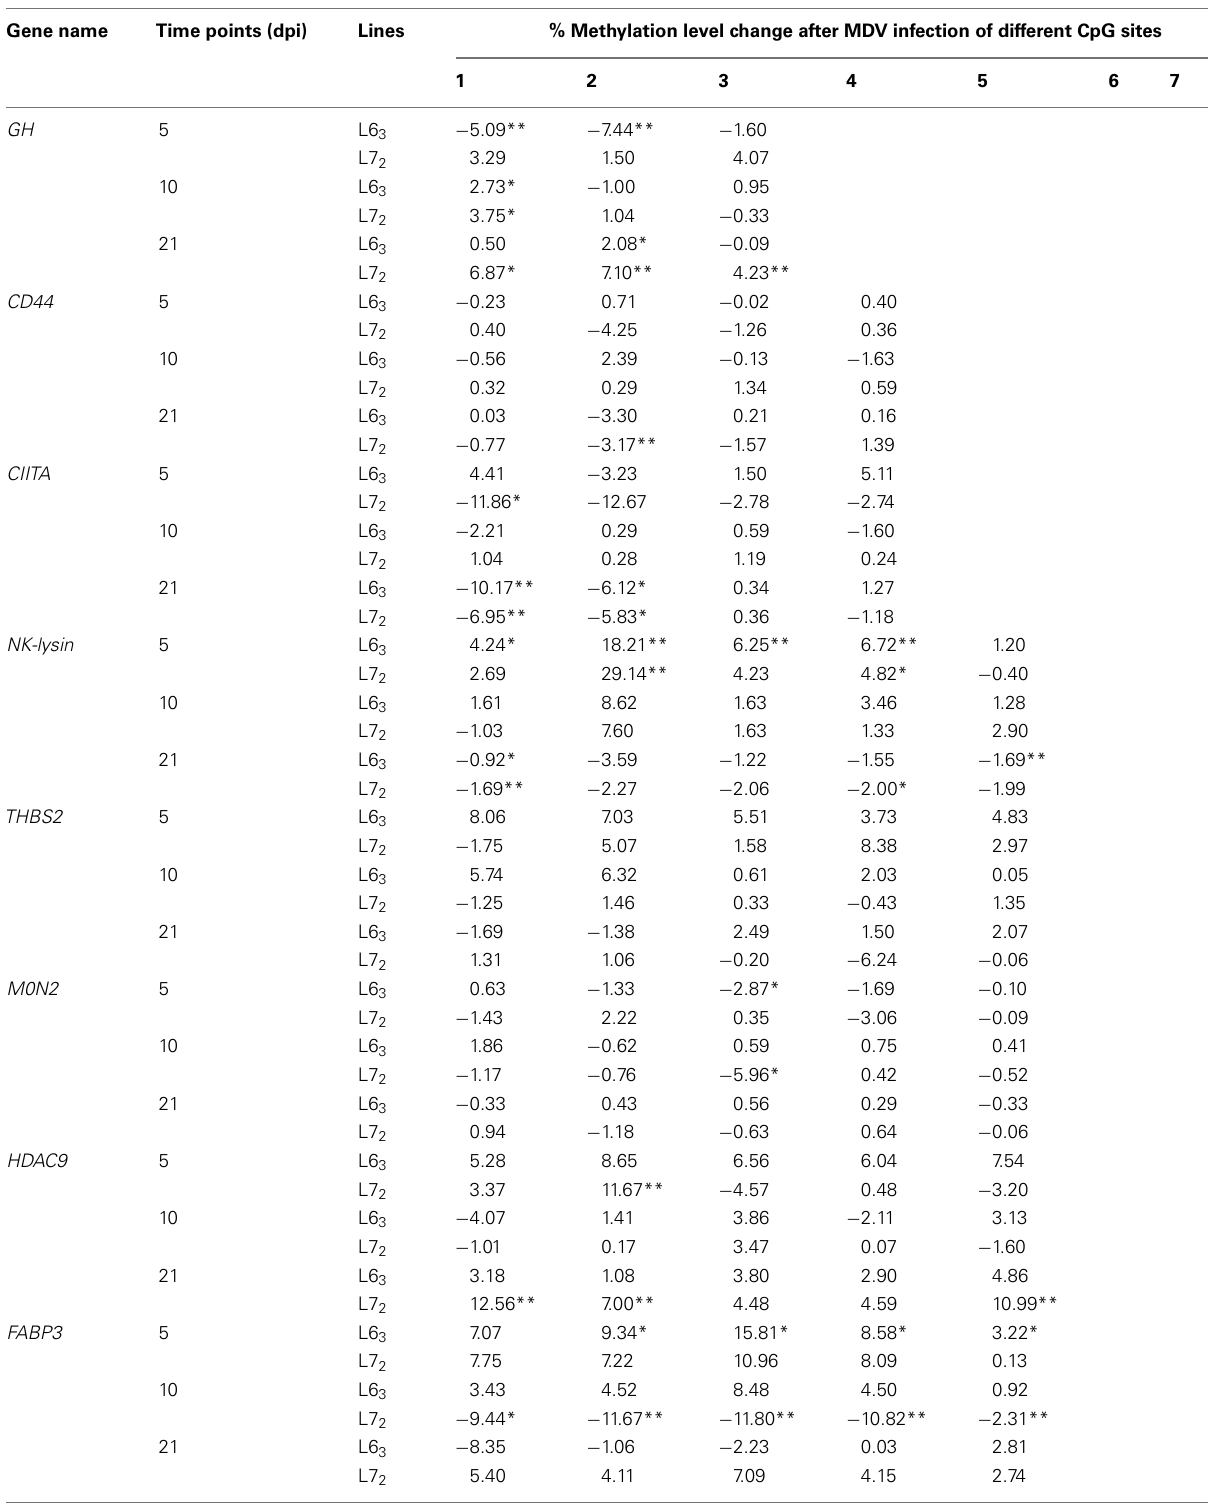
TableA4 | Promoter methylation level change at different CpG sites of genes after MDV